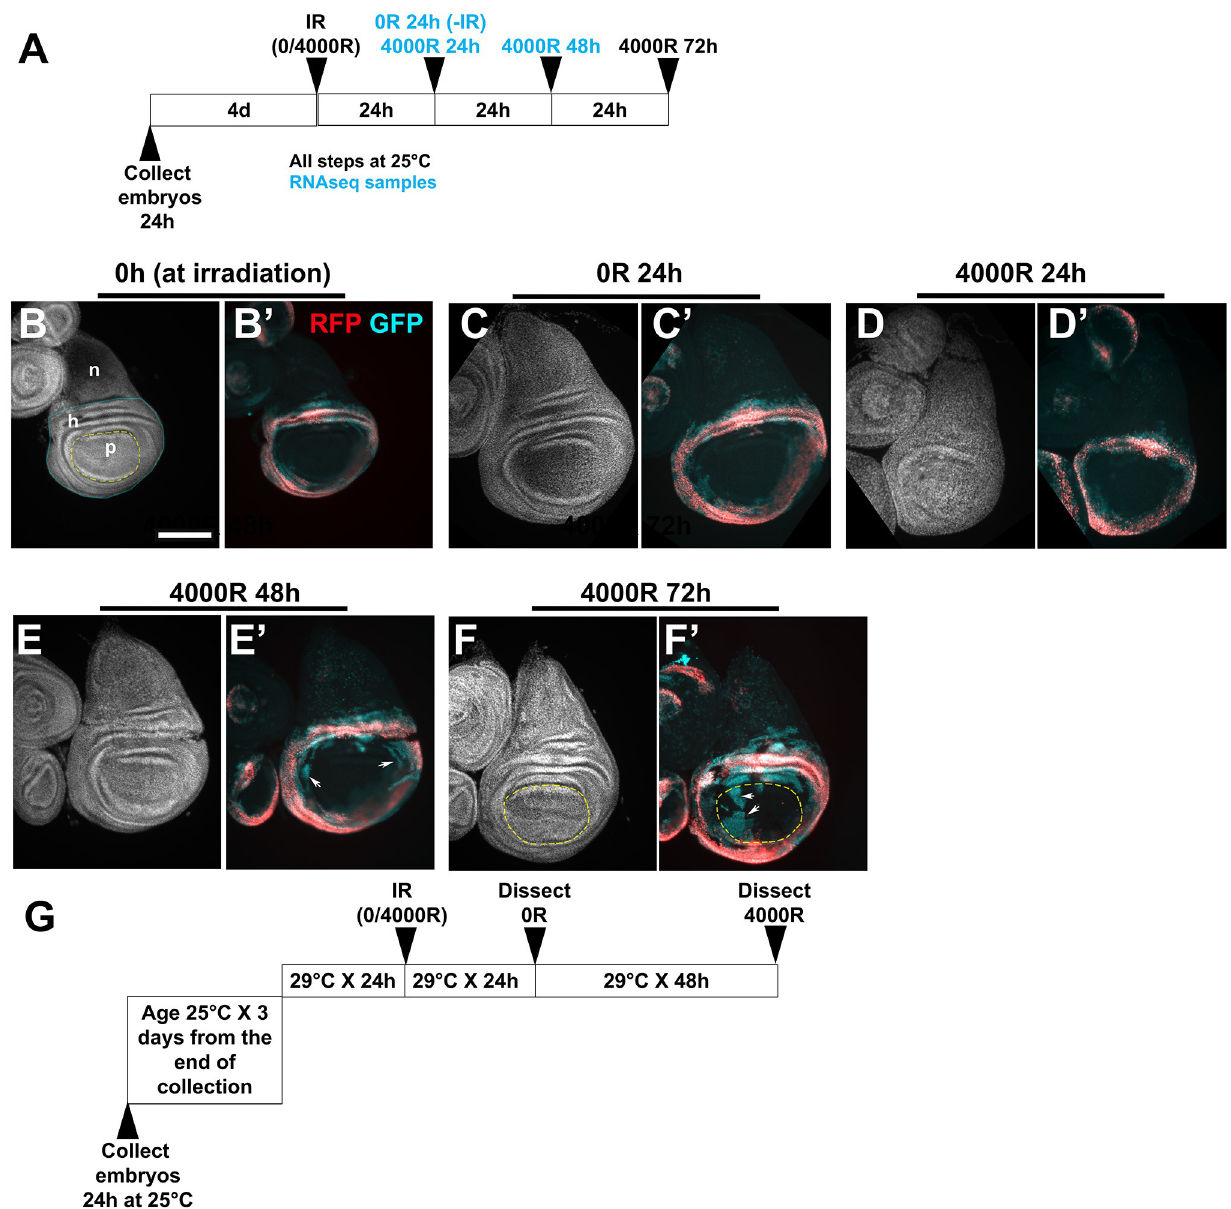
Fig 1. Lineage tracing to monitor cell fate changes after irradiation. Larvae expressing G-trace under the control of 30A-GAL4 were irradiated with 0 or 4000R of X-rays. The discs were dissected at various times shown after irradiation, fixed, stained for DNA and imaged for DNA, RFP and GFP. The larvae were of the genotype w 1118 /+ or Y; 30A-GAL4 > UAS-G-trace/+ produced by a cross between w 1118 and 30A-GAL4 > UAS-G-trace/SM5 and sorted for RFP/GFP. Scale bar = 100 microns. (A) The protocol used to generate the samples for RNAseq. (B-F) Representative discs from various time points. (B-B’) show discs at the time of irradiation. Note the overlap of RFP and GFP, indicating little fate plasticity, and the absence of GFP + cells in the pouch within the yellow line in B. DNA images are used to discern the different regions of the disc; n = notum, h = hinge, p = pouch. (C-C’) show an unirradiated disc at 24h after mock irradiation, the time point for -IR RNAseq samples. (D-D’) show an irradiated disc at 24h after IR, showing little fate change. The IR+24h RNAseq samples were from such discs. (E-E’) show an irradiated disc at 48h after IR, showing the first indications of fate change as seen by RFP - GFP + cells (arrows). Similar results are seen also in larvae that were irradiated 3 days from the end of egg collection. The IR+48h RNAseq samples included larvae irradiated 3 or 4 days from the end of egg collection. (F-F’) show an example of a disc with fate change as indicated by RFP - GFP + cells (arrows) in the pouch (yellow circle). Such fate change was seen at the IR+72h time point when larvae were irradiated 3d (shown here) or 4d from the end of egg collection [14]. (G) The temperature shift and irradiation protocol used in the functional tests. The temperature shift inactivates GAL80 ts that was present in the crosses for the functional